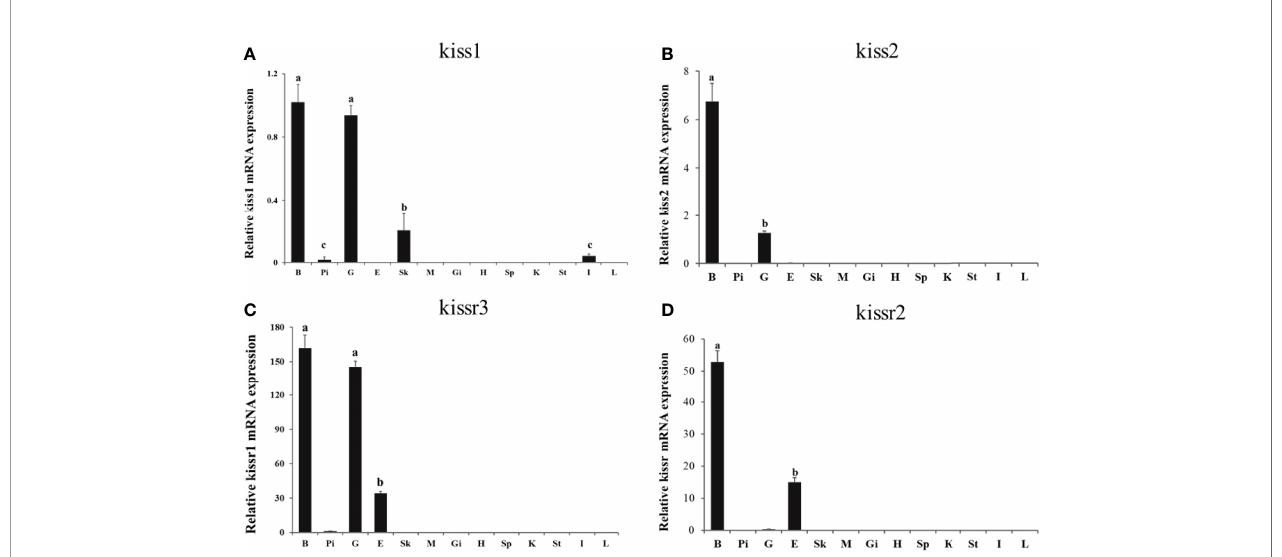
FIGURE 4 | Tissue distribution of kiss/kissr genes in turbot. (A) kiss1, (B) kiss2, (C) kissr3, (D) kissr2. The relative abundance of kiss/kissr genes were expressed as mean ± SEM (n=3). Tissue abbreviations: B, brain; Pi, pituitary; G, gonad; E, eye; Sk, skin; M, muscle; Gi, gill; H, heart; Sp, spleen; K, kidney; St, stomach; I, intestine; L, liver. Different letters above bars represent statistical signi fi cance (p < 0.05) between two different